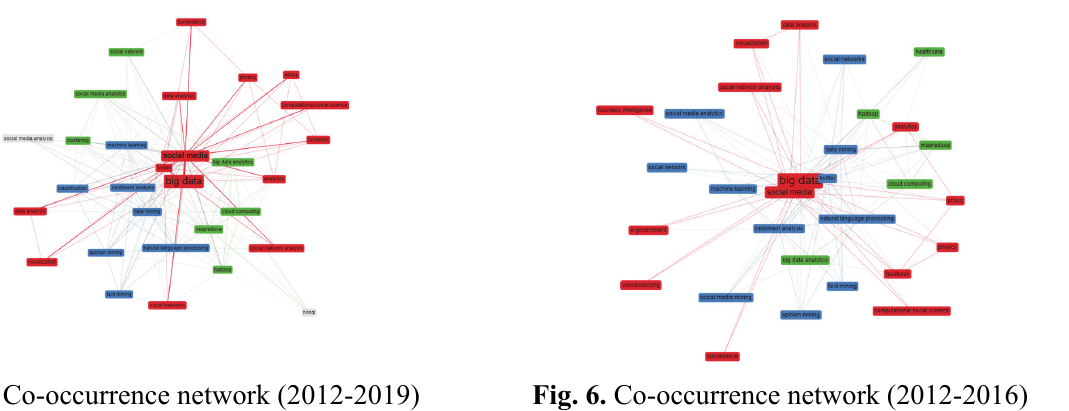
Fig. 5. Co-occurrence network (2012-2019) Fig. 6. Co-occurrence network